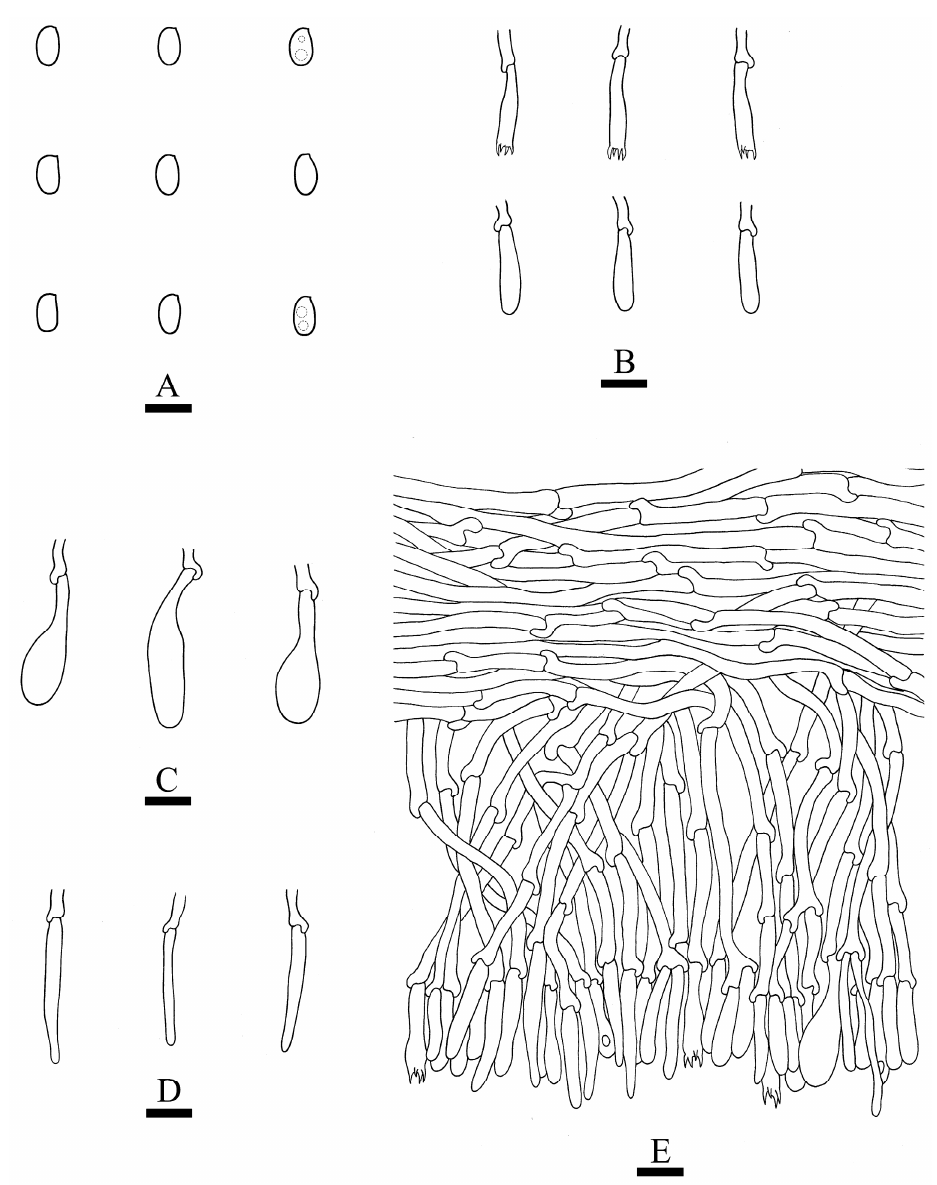
Figure 14. Microscopic structures of Phlebia niveomarginata (drawn from CLZhao 19089, holotype). ( A ) Basidiospores. ( B ) Basidia and basidioles. ( C ) Cystidia. ( D ) Cystidioles. ( E ) A section of hymenium. Bars: ( A ) = 5 µm, ( B – E ) = 10 µm.